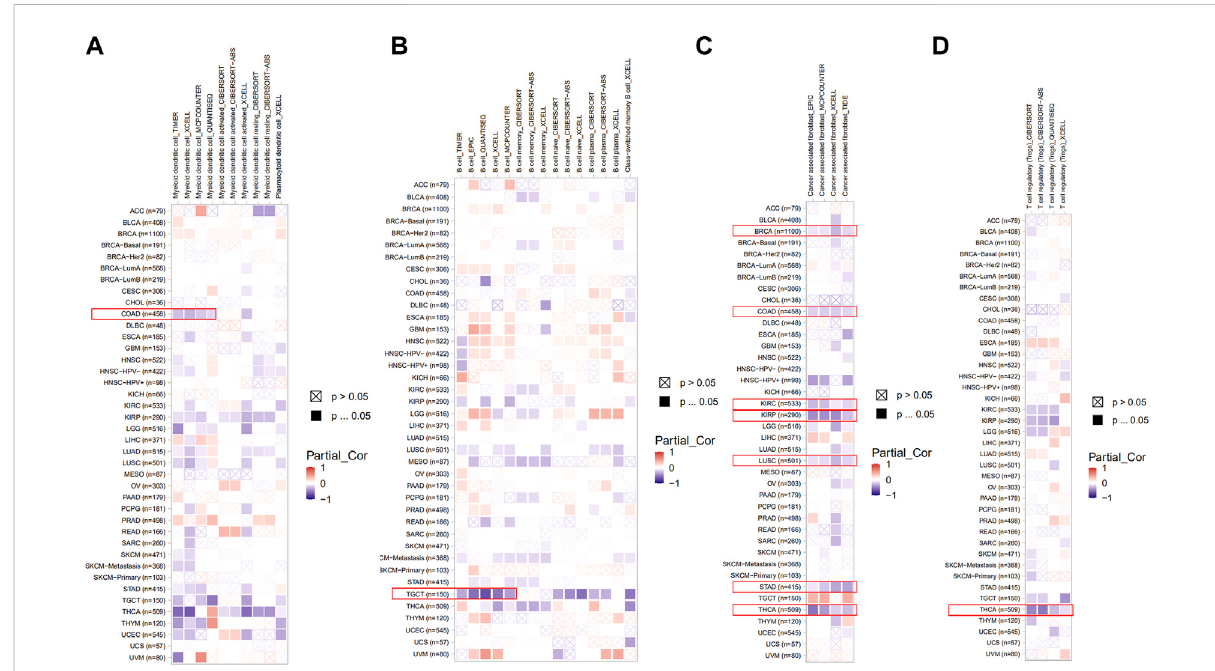
FIGURE 5 Roles of PDHA1 in the immune in fi ltration in all TCGA tumor types. (A – D) Correlation heatmap between PDHA1 expression and tumor- in fi ltratingimmunecellsacross33cancertypeswasdisplayed,includingDC (A) ,Bcell (B) ,CAF (C) ,andTregs (D) .Apositivecorrelationwasmarkedas red color, while a negative correlation was marked as blue color. Nonsigni fi cant correlations values were marked with a